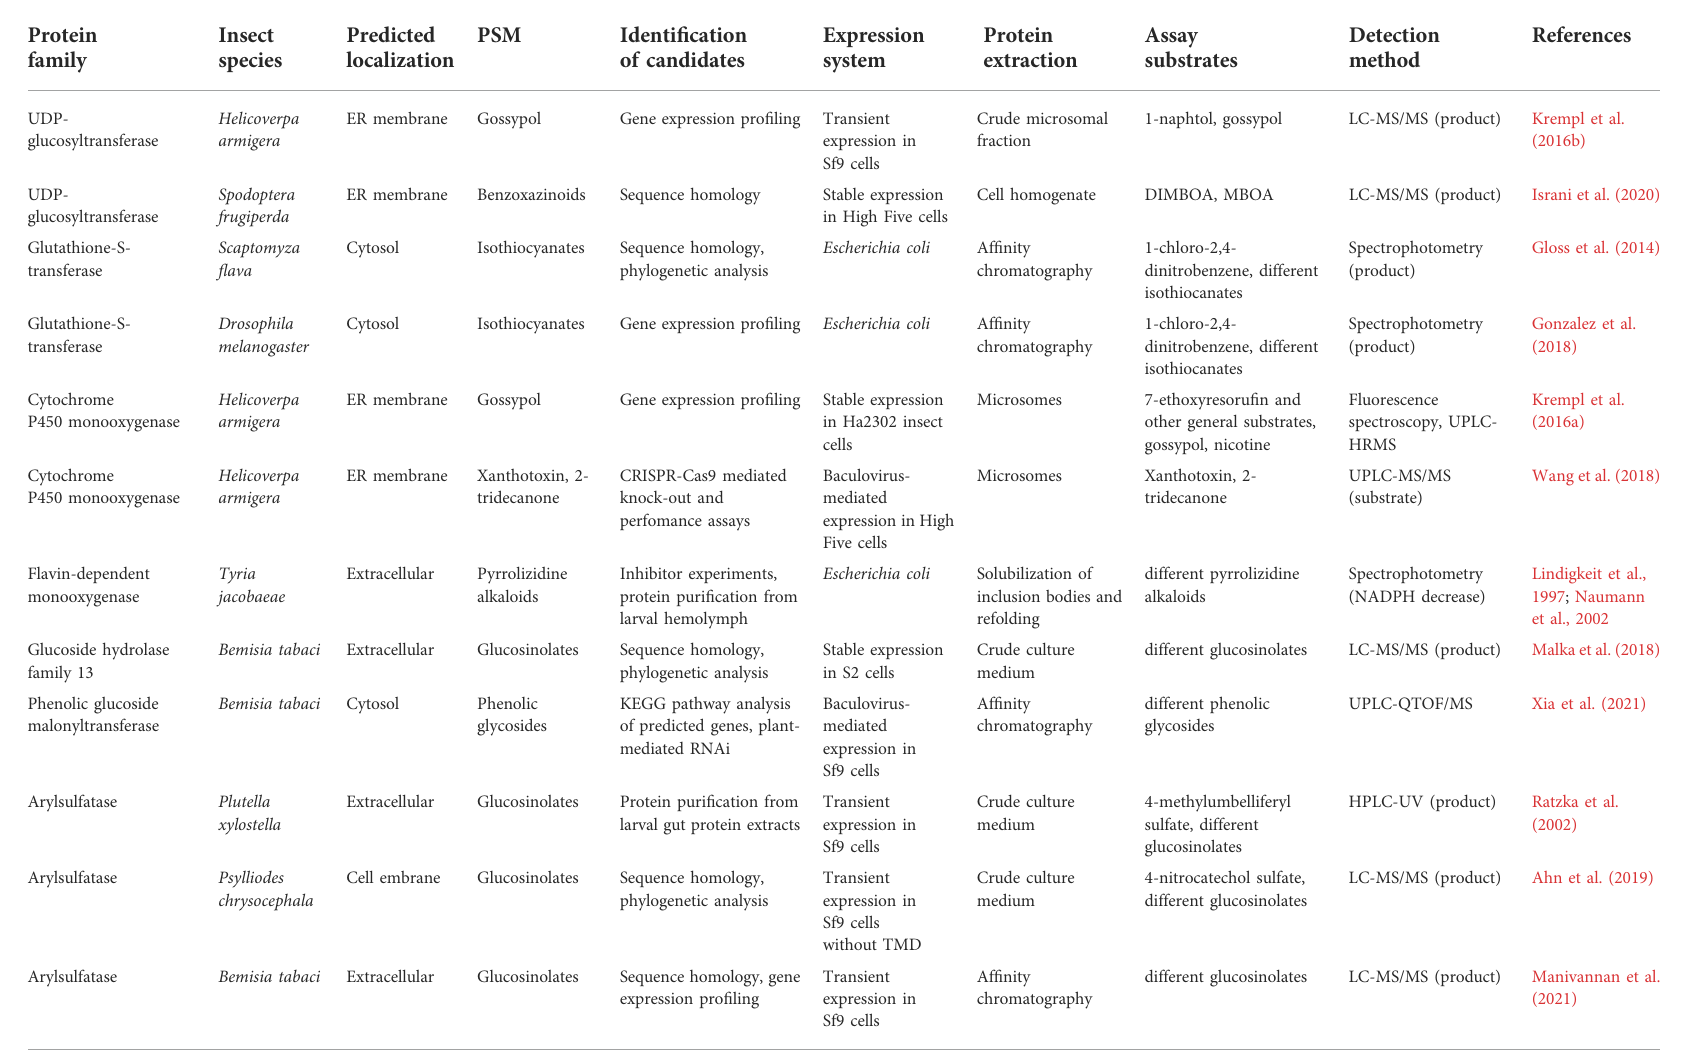
TABLE 1 Examples of identi fi ed PSM metabolization and transport